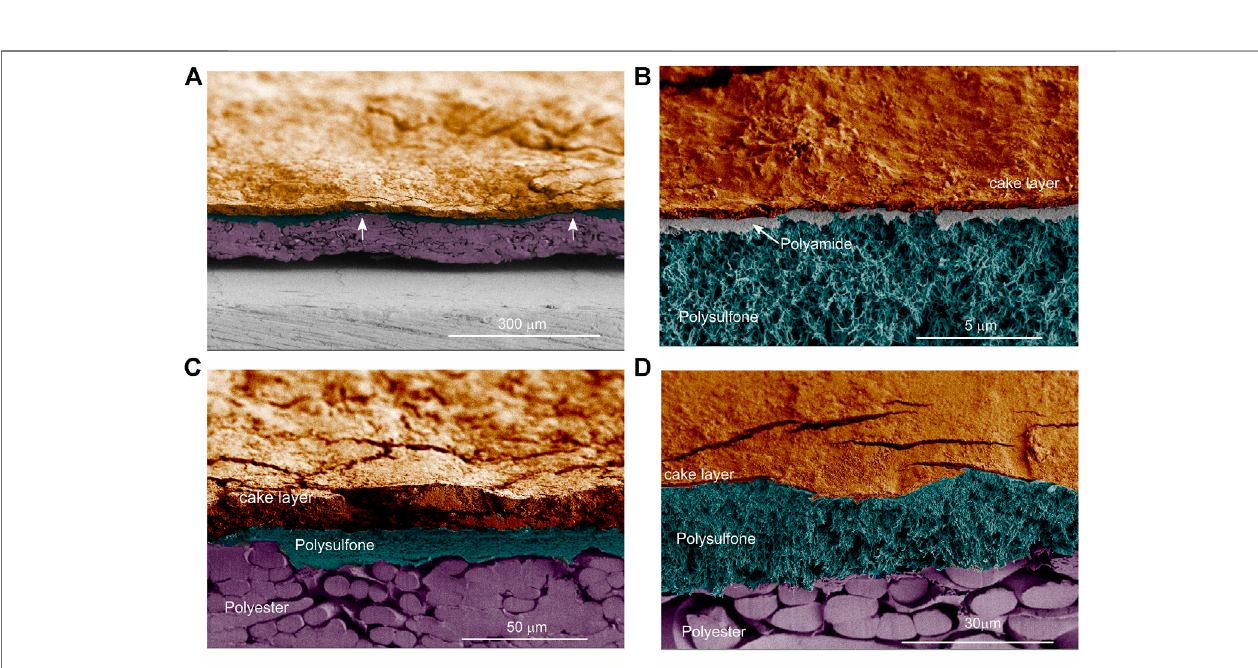
FIGURE 6 | Scanning electron images of cross-sectioned membrane samples. (A) A general overview of the membrane and the cake layer. The arrows indicate points where the polysulfone was barely visible along the membrane. (B) The polyamide layer is visible, and the cake layer covers the membrane homogenously. (C) Compressed polysulfone layer where only the laminar-like polysulfone structure is visible. (D) The spongy-like polysulfone structure is visible. Images were pseudo- colored to ease visualizing the distinctive features of the membrane.